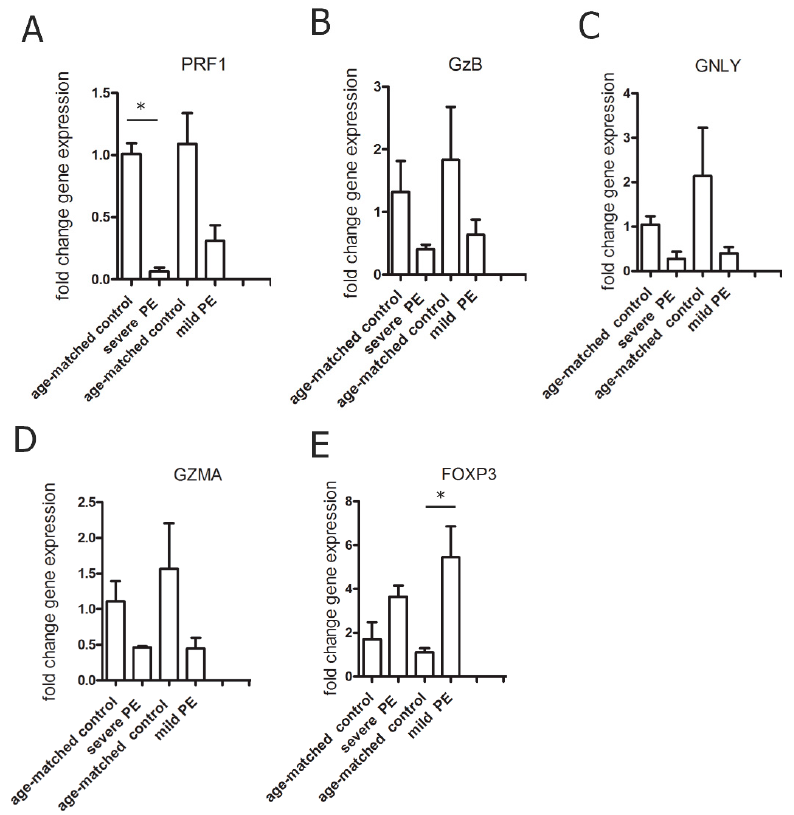
Figure 6. qPCR mRNA fold change of ( A ) PRF1, ( B ) GzB, ( C ) GNLY, ( D ) GZMA, and ( E ) FOXP3